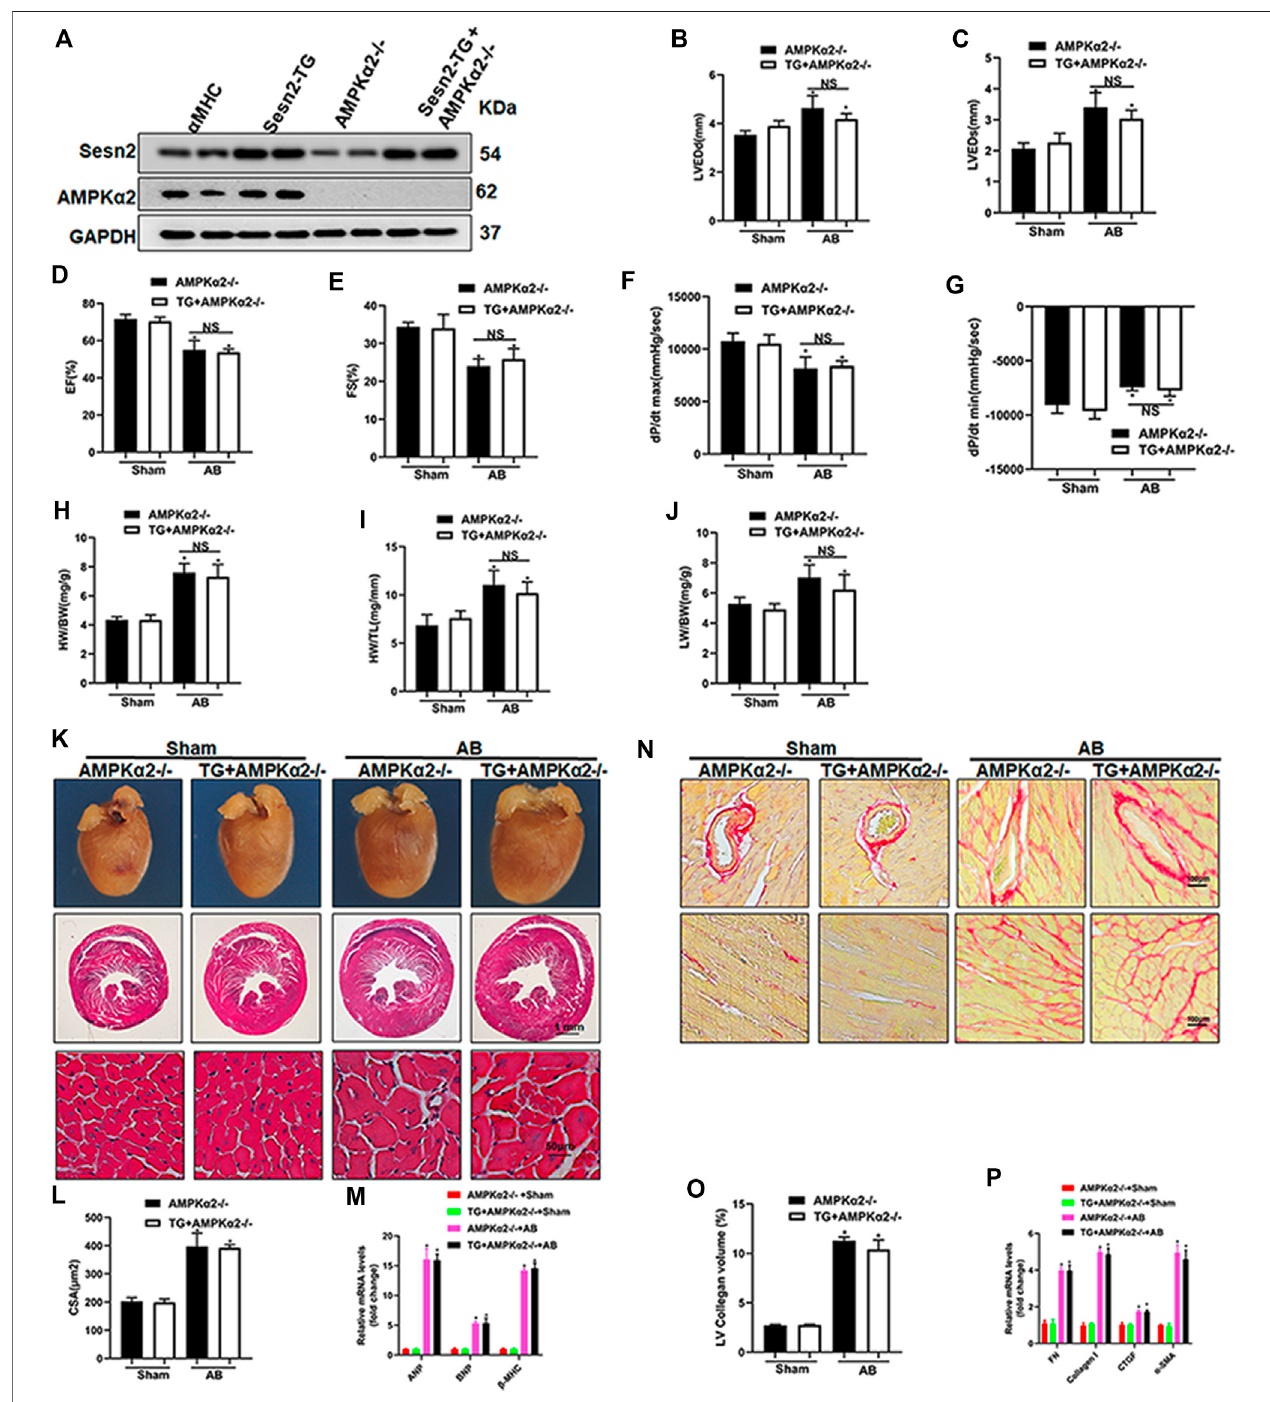
FIGURE 6 | Sesn2 overexpression could not protect against cardiac remodeling in AMPK α 2 knockout mice. (A) Representative Western blots of Sesn2 and AMPK α 2( n (cid:1) 6).Echocardiographyandpressure-volumeloopparametersdetectedmousecardiacfunctionat8 weeksaftershamorABsurgery( n (cid:1) 6): (B) LVEDd, (C) LVEDs, (D) EF, (E) FS, (F) dp/dtmax and (G) dp/dtmin. The ratios of (H) HW/BW, (I) HW/TL and (J) LW/BW at 8 weeks after sham or AB surgery ( n (cid:1) 9). (K) Representative images of gross hearts and HE-stained heart sections ( n (cid:1) 6). (L) Quantitative measurements of cell surface area (CSA) of cardiomyocytes ( n (cid:1) 60) ( n ≥ 100left ventricular cells). (M) RT-PCR detected ANP, BNP and β MHC mRNA expression ( n (cid:1) 6). (N) Representative images ofPSR staining( n (cid:1) 6). (O) Quantitative resultsoftheleftventricularcollagenvolume( n (cid:1) 6). (P) RT-PCRdetectedFN,CollagenI,CTGF,and α -SMAmRNAexpression.Thedatawereexpressedasthemean ± SD. * p < 0.05 vs. indicated group. One-way analysis of variance (ANOVA) followed by Tukey post hoc tests were used for signi fi cance analysis.